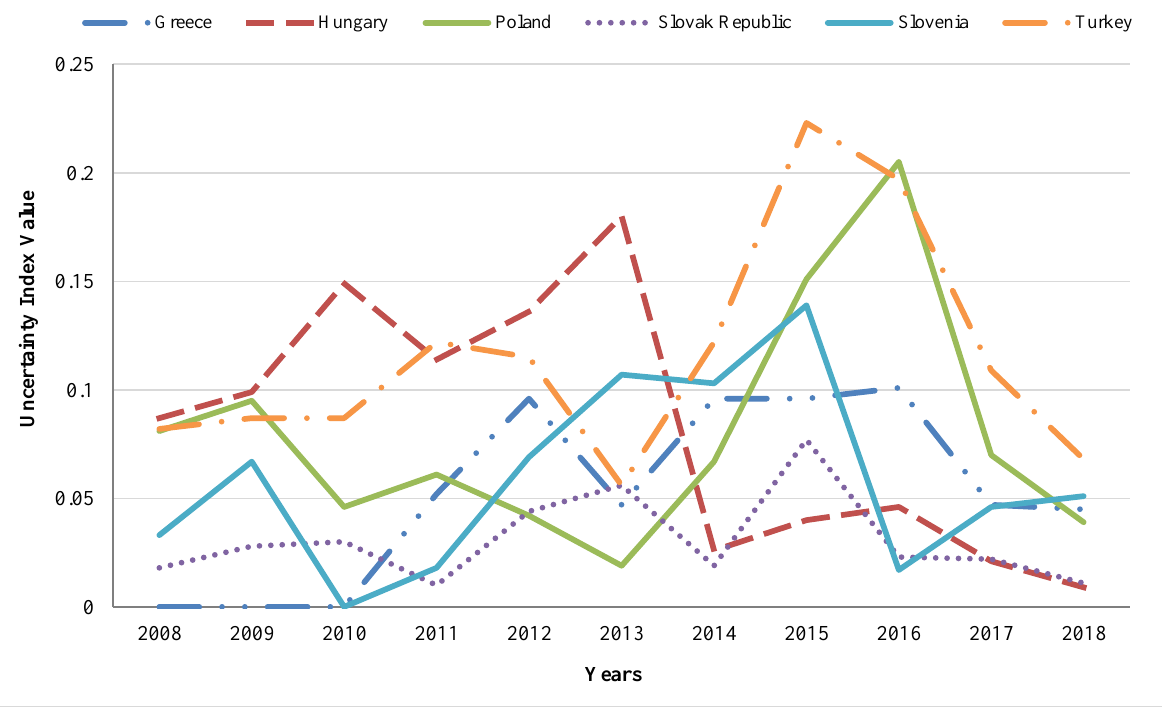
Figure 2. Uncertainty Index in Selected EU Countries (2008–2018)